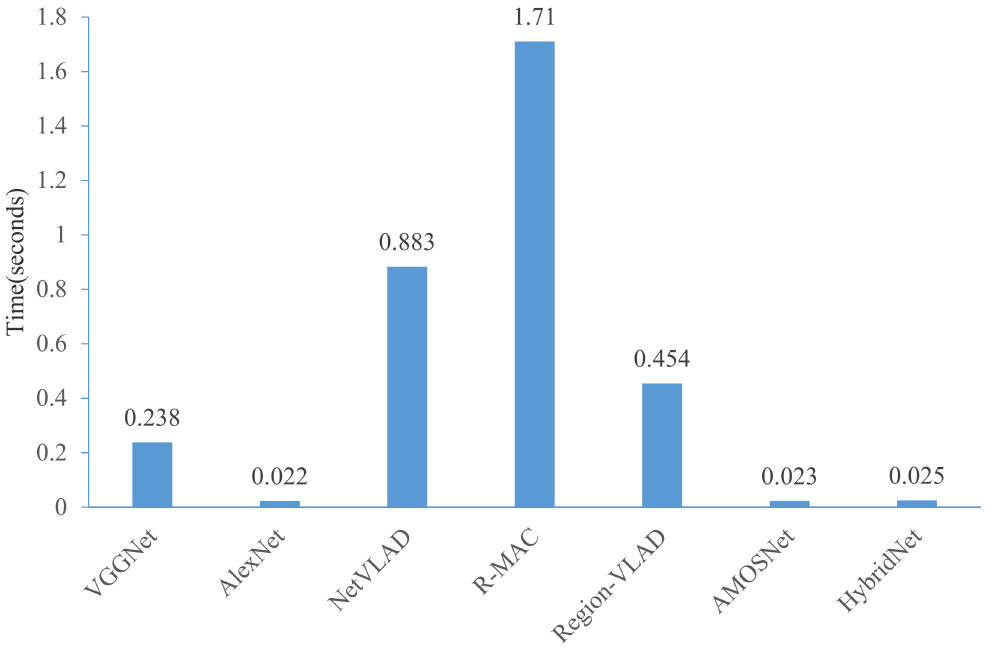
Figure 13. Comparison on feature extraction time.